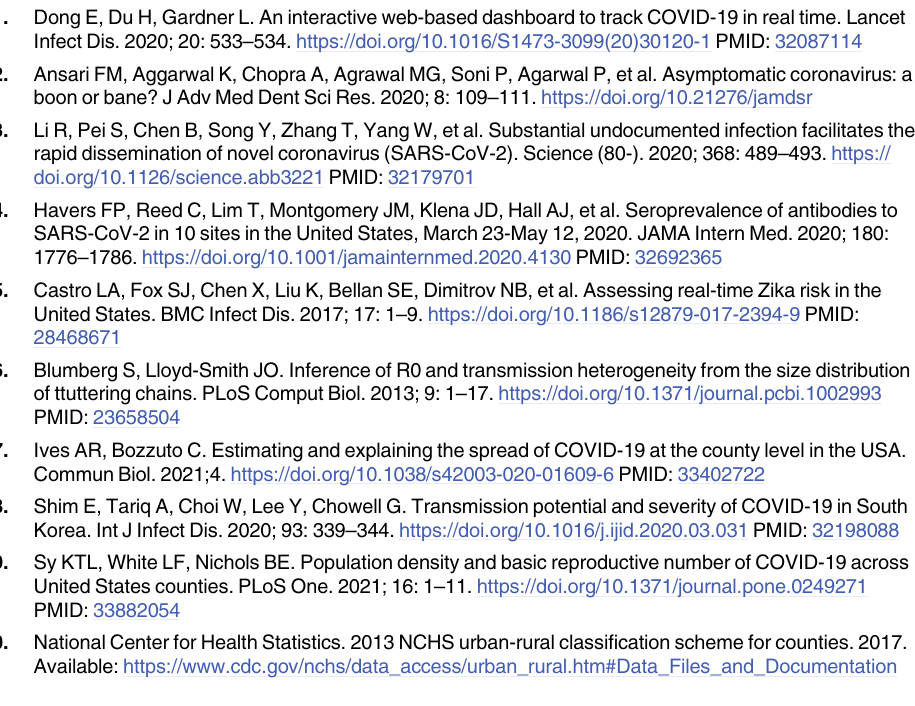
(1.05, bottom row). For R = 0.95 0.0% of original and 0.003% of retrospective simulations e reached 2,000 cumulative infections and met a minimum prevalence of 50 new infections. As increased to 1.05, 0.11% of original and 0.10% of retrospective simulations were classified as R e epidemics. Ending simulations at 2,000 cumulative infections and requiring a minimum prev- alence of 50 new infections per day is sufficient to distinguish self-limiting simulations from